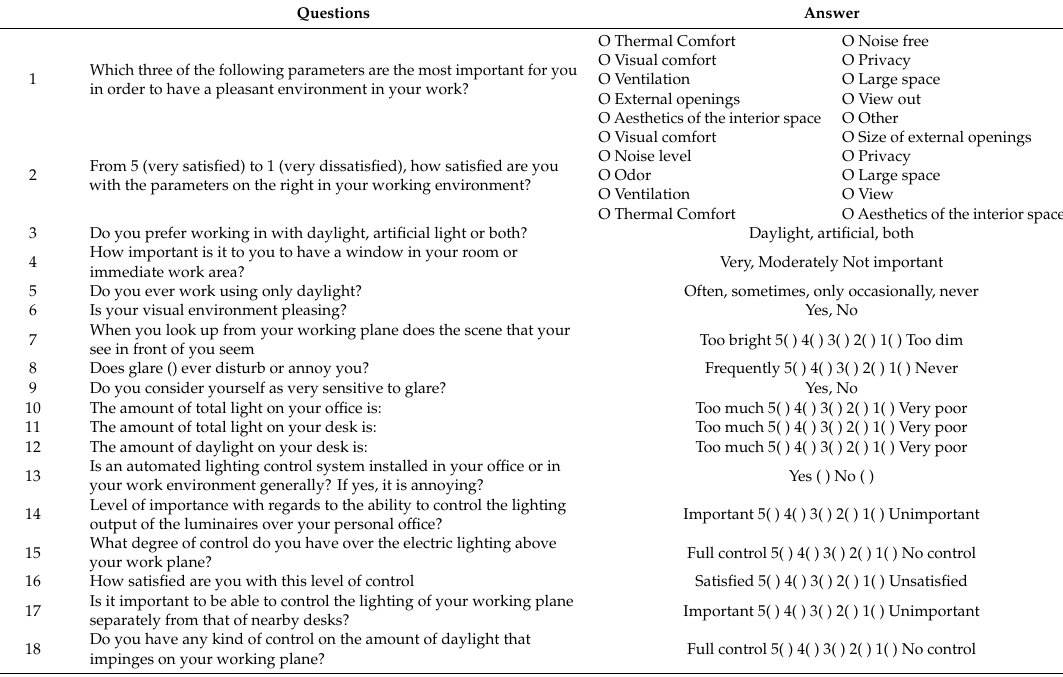
Figure 6. Number of occupants that completed the POE (left), and their age frequency distribution (right). Table 2. The questionnaire given to the occupants of the buildings.